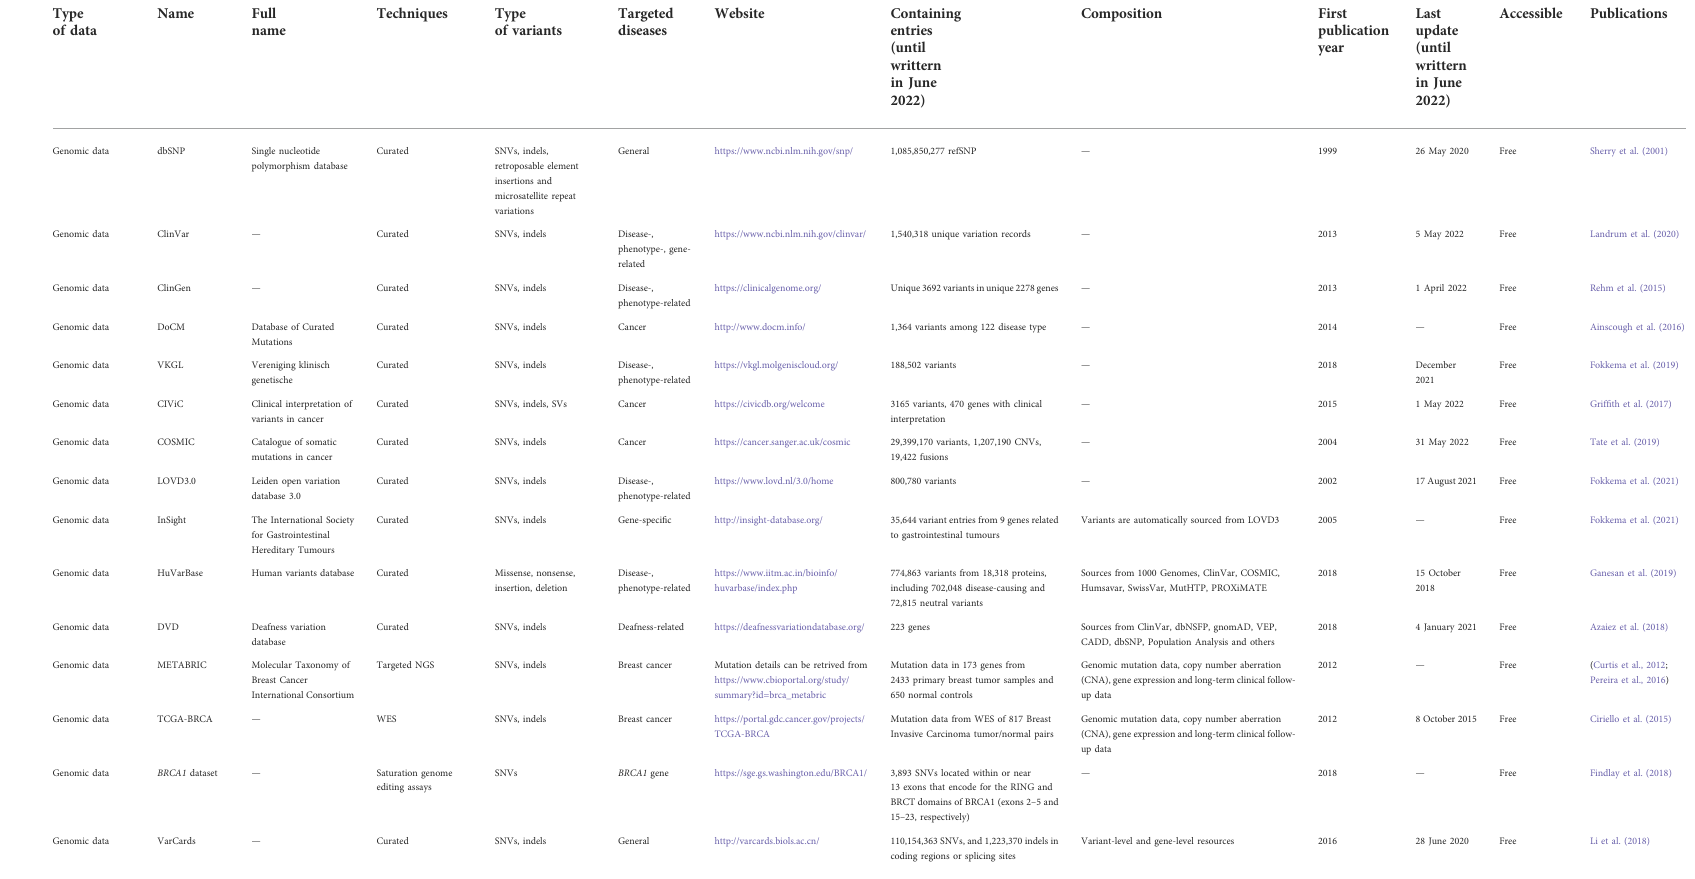
TABLE 1 ( Continued ) Summary of resources for human genotypes and phenotypes relationships. Type of